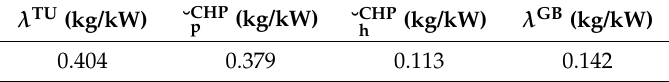
Table 2. Standard coal consumption per kilowatt hour of each